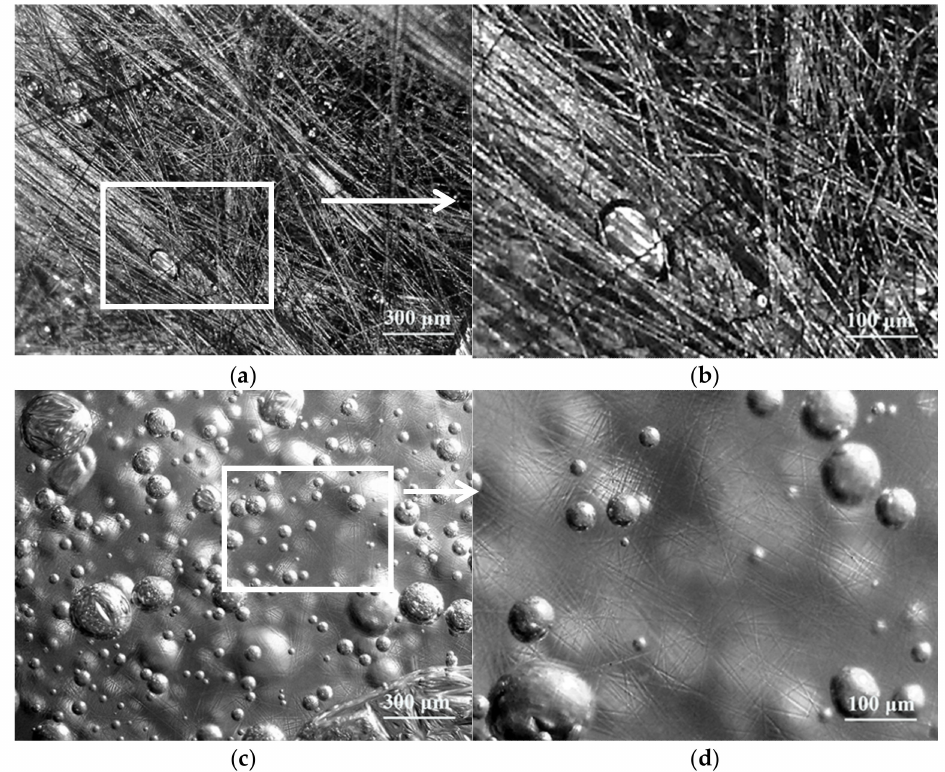
Figure 10. The distribution of 6.0 mm chopped carbon fibers with a content of 4.00 phr ( a , b ) and 6.0 mm chopped carbon fibers with a content of 4.00 phr ( c , d ) in resin